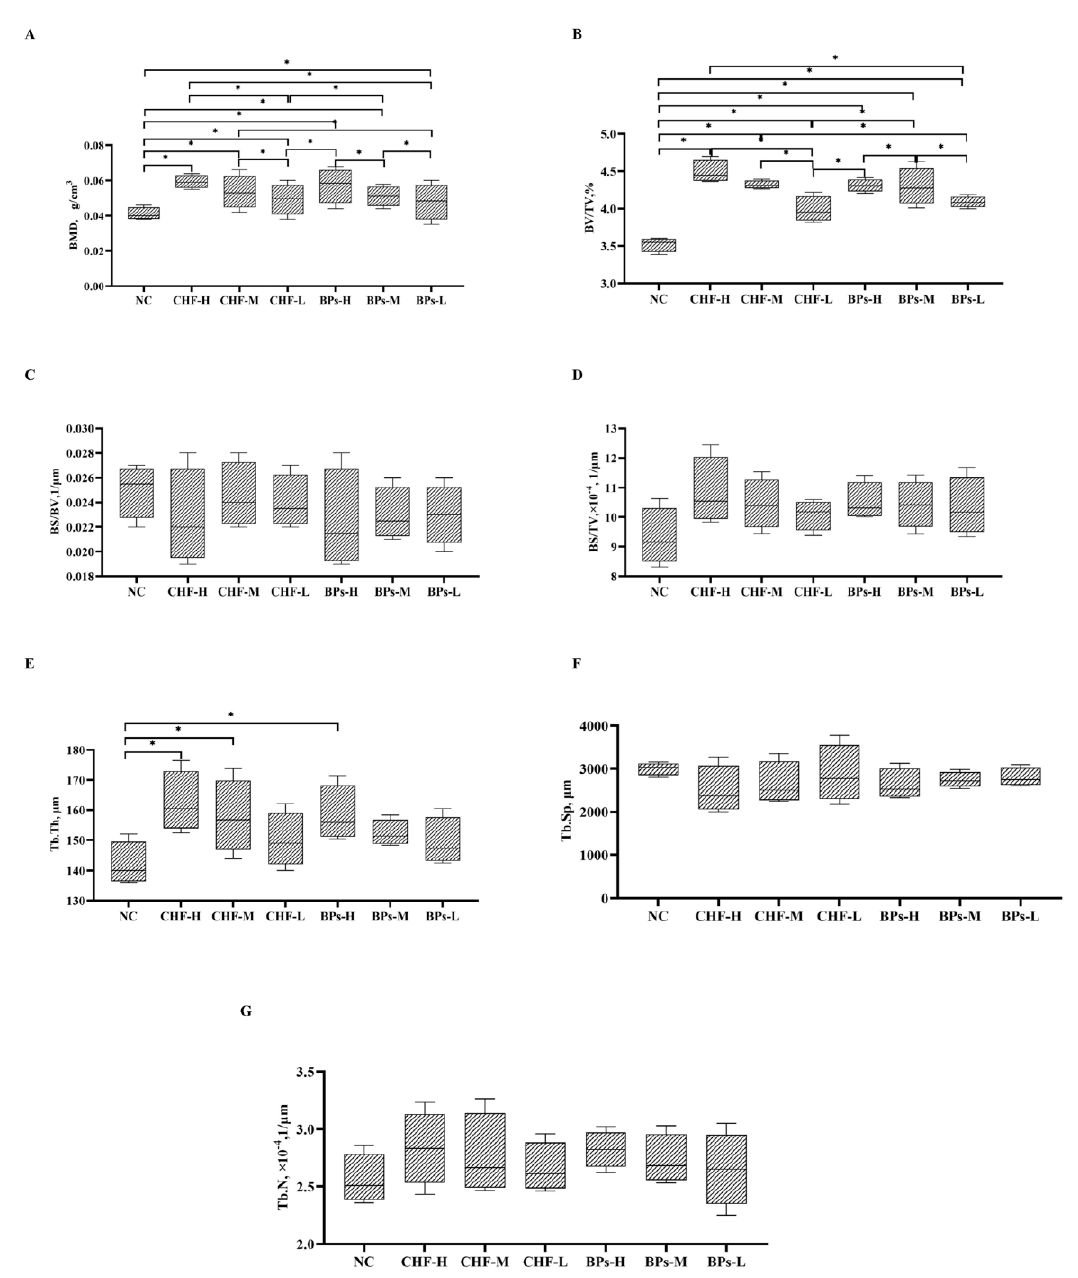
Figure 2. 3D structure of cancellous bone of distal femur at 60 days of age. ( A ) Longitudinal section of the distal cancellous bone of the femur in the NC group. ( B ) Cross ‐ section of the distal cancellous bone of the femur in the NC group. ( C ) Longitudinal section of distal femur cancellous bone in CHF ‐ H group. ( D ) Cross ‐ section of distal femur cancellous bone in CHF ‐ H group. ( E ) Longitudinal section of distal femur cancellous bone in CHF ‐ M group. ( F ) Cross ‐ section of distal femur cancellous bone in CHF ‐ M group. ( G ) Longitudinal section of distal femur cancellous bone in CHF ‐ L group. ( H ) Cross ‐ section of distal femur cancellous bone in CHF ‐ L group. ( I ) Longitudinal section of distal femur cancellous bone in BPs ‐ H group. ( J ) Cross ‐ section of distal femur cancellous bone in BPs ‐ H group. ( K ) Longitudinal section of the distal cancellous bone of the femur in the BPs ‐ M group. ( L ) Cross ‐ section of the distal femur cancellous bone in the BPs ‐ M group. ( M ) Longitudinal section of distal femur cancellous bone in BPs ‐ L group. ( N ) Cross section of distal femur cancellous bone in BPs ‐ L group.